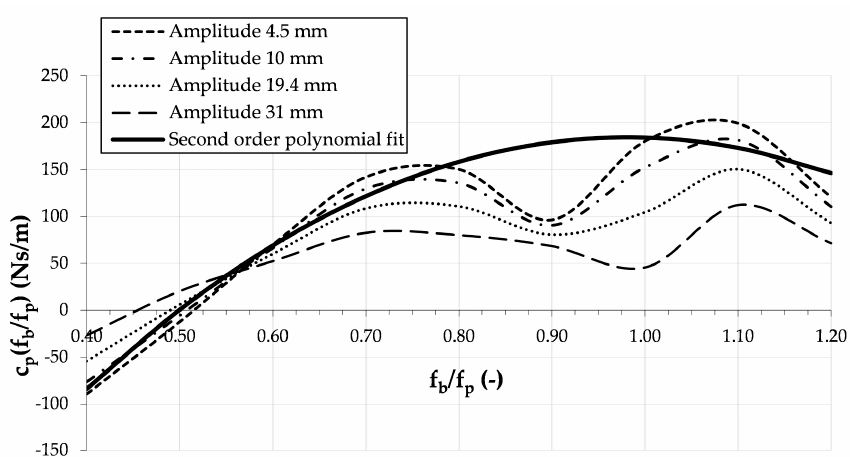
Figure 3. Statistical characterisation of damping coe ffi cient cp(fb / fp) lateral amplitude dependent [17] vs. polynomial best fit lateral amplitude independent [42].